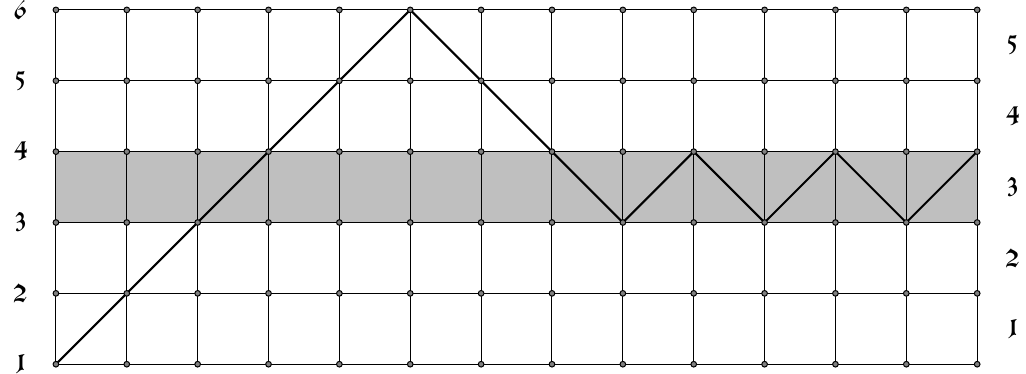
Figure 11 . A non-minimal path in the restricted solid-on-solid model L 2 ; 7 with a peak at ( x; y ) = (0 ; 5) of weight 5.